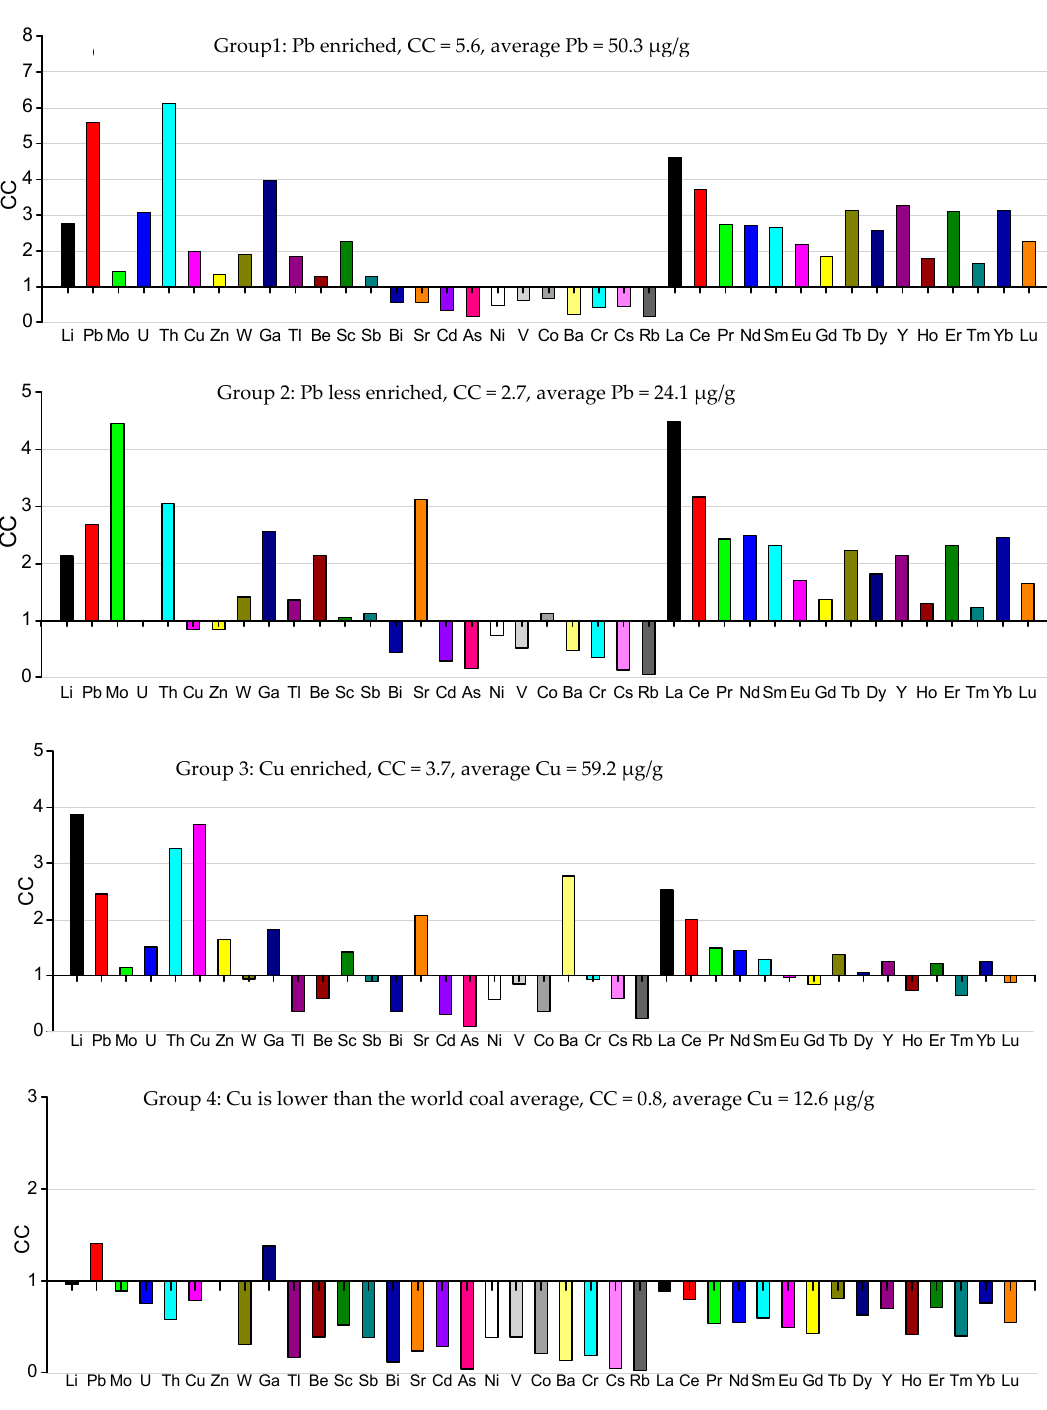
Figure 6. Concentration coefficients of trace elements in the Jungar coals vs. world low-rank coal. Data for trace elements in world low-rank coal were obtained from Ketris and Yudovich [30].